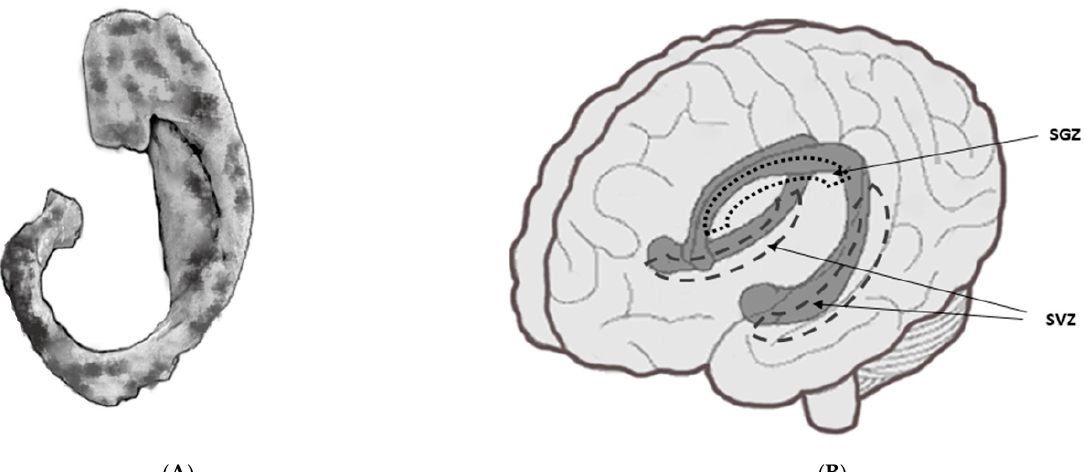
Figure 1. The sketch of hippocampus ( A ) and localization of neural progenitor cells of hippocampus ( B ). SGZ—subgranular zone, SVZ—subventricular zone.